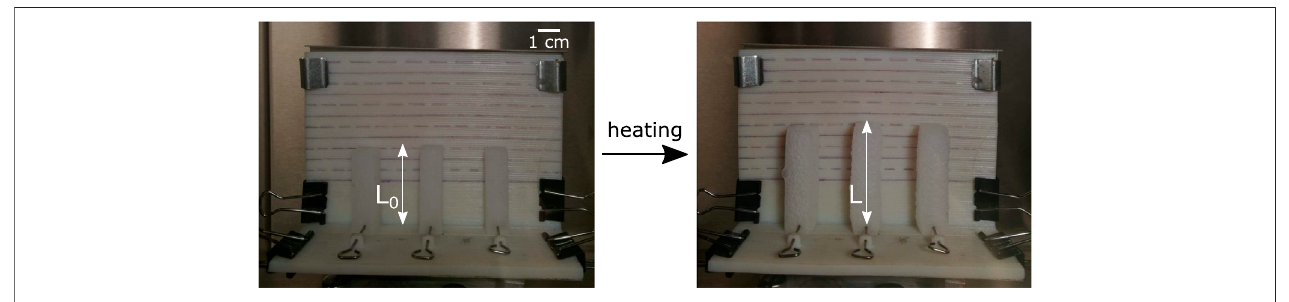
FIGURE 3 | Experimental actuation strain measurement setup.